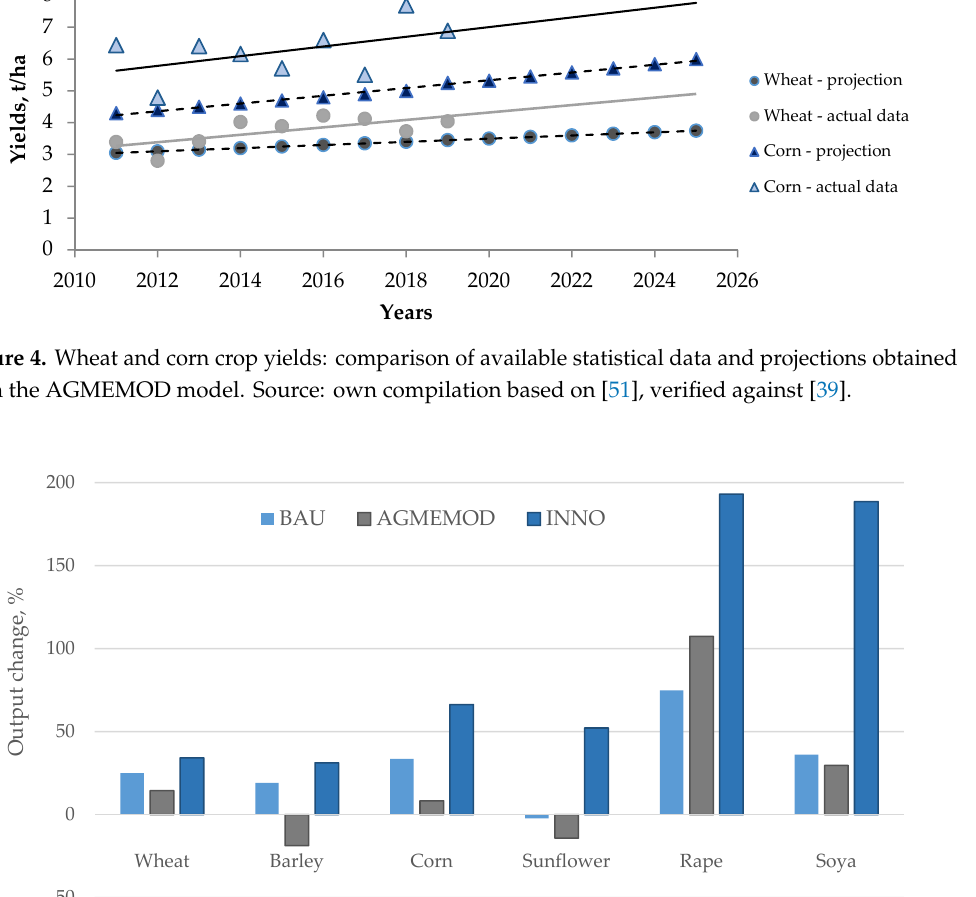
Figure 5. Projection of production (output) change for selected crops by 2030 (compared to 2008–2014 average volumes). Source: own calculations.